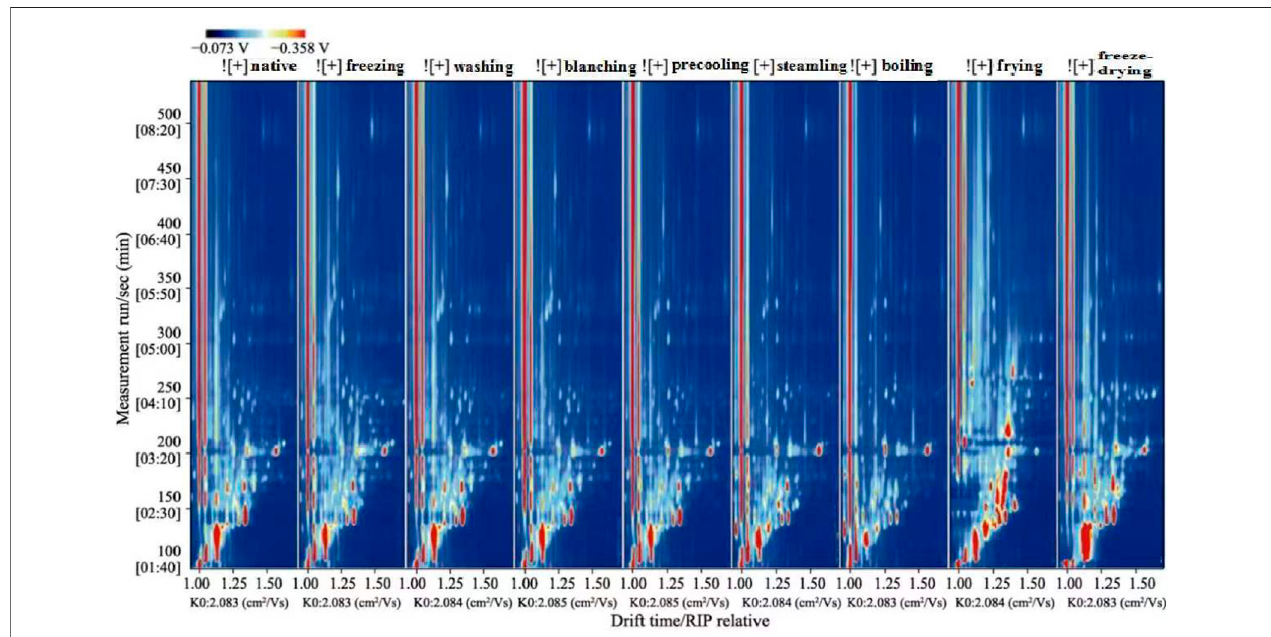
FIGURE 1 | Two-dimensional spectrum of volatile compounds in corn under nine kinds of different treatments (top view).